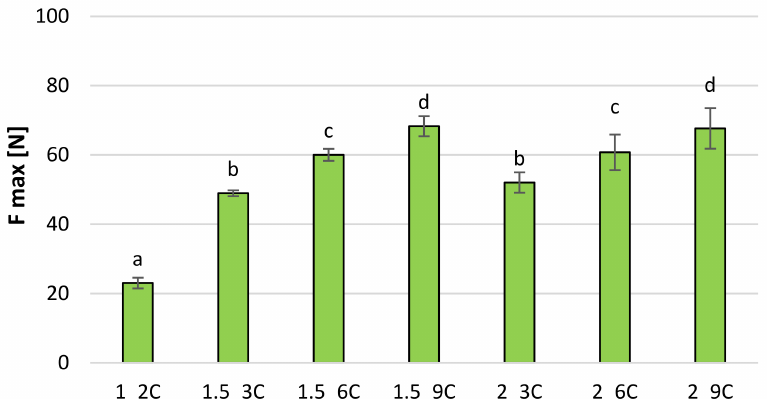
Figure 7. The maximum cutting force [N] of freeze-dried fruit bars with chokeberry pomace. Mean values marked with the same index letter (a–d) do not differ statistically significantly at the level of p = 0.05. Denotations in Table 1 include Index (C) next to the sample symbol—bars with the chokeberry